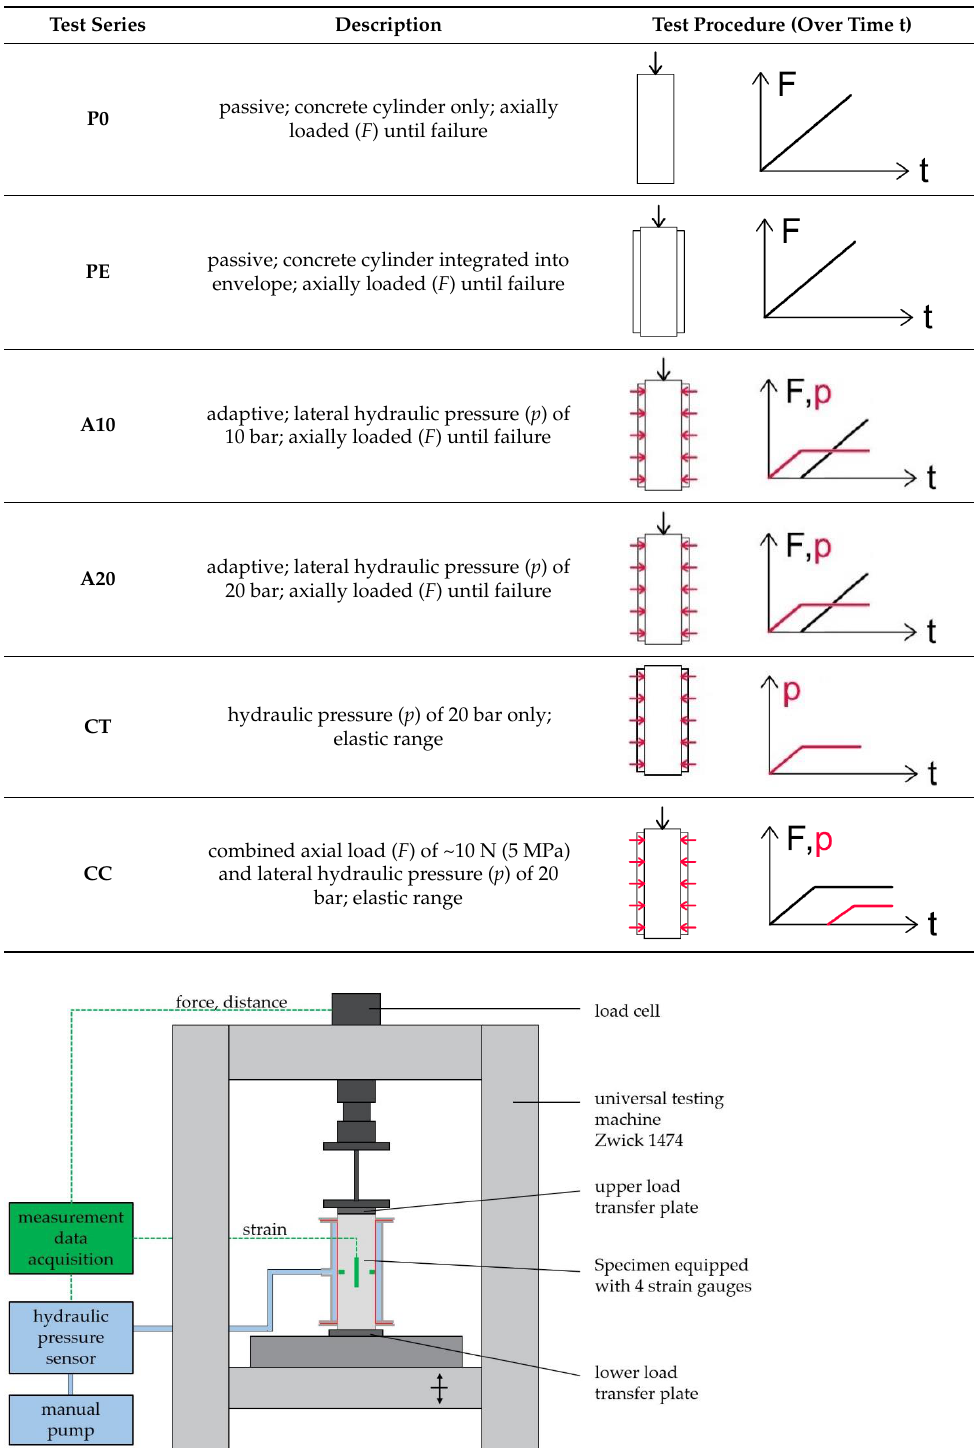
Figure 5. Schematic of the test setup for test series A10, A20 and CC. Table 2. Overview of the testing program.